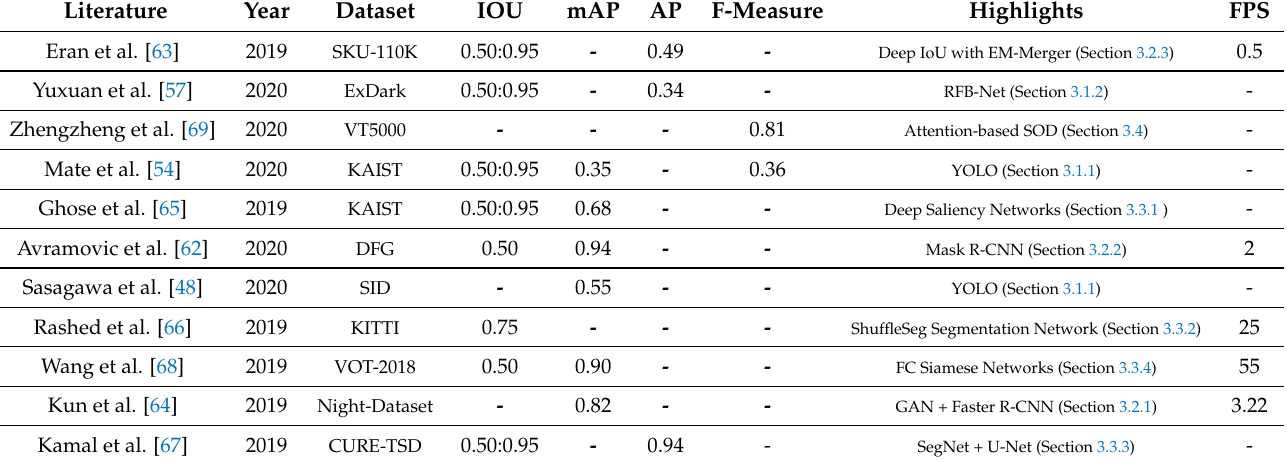
Table 3. Object detection performance analysis in challenging environments. IOU represents intersection over union threshold, whereas mAP and AP denote mean average precision and average precision, respectively. FPS represents frames per second calculated at inference time.